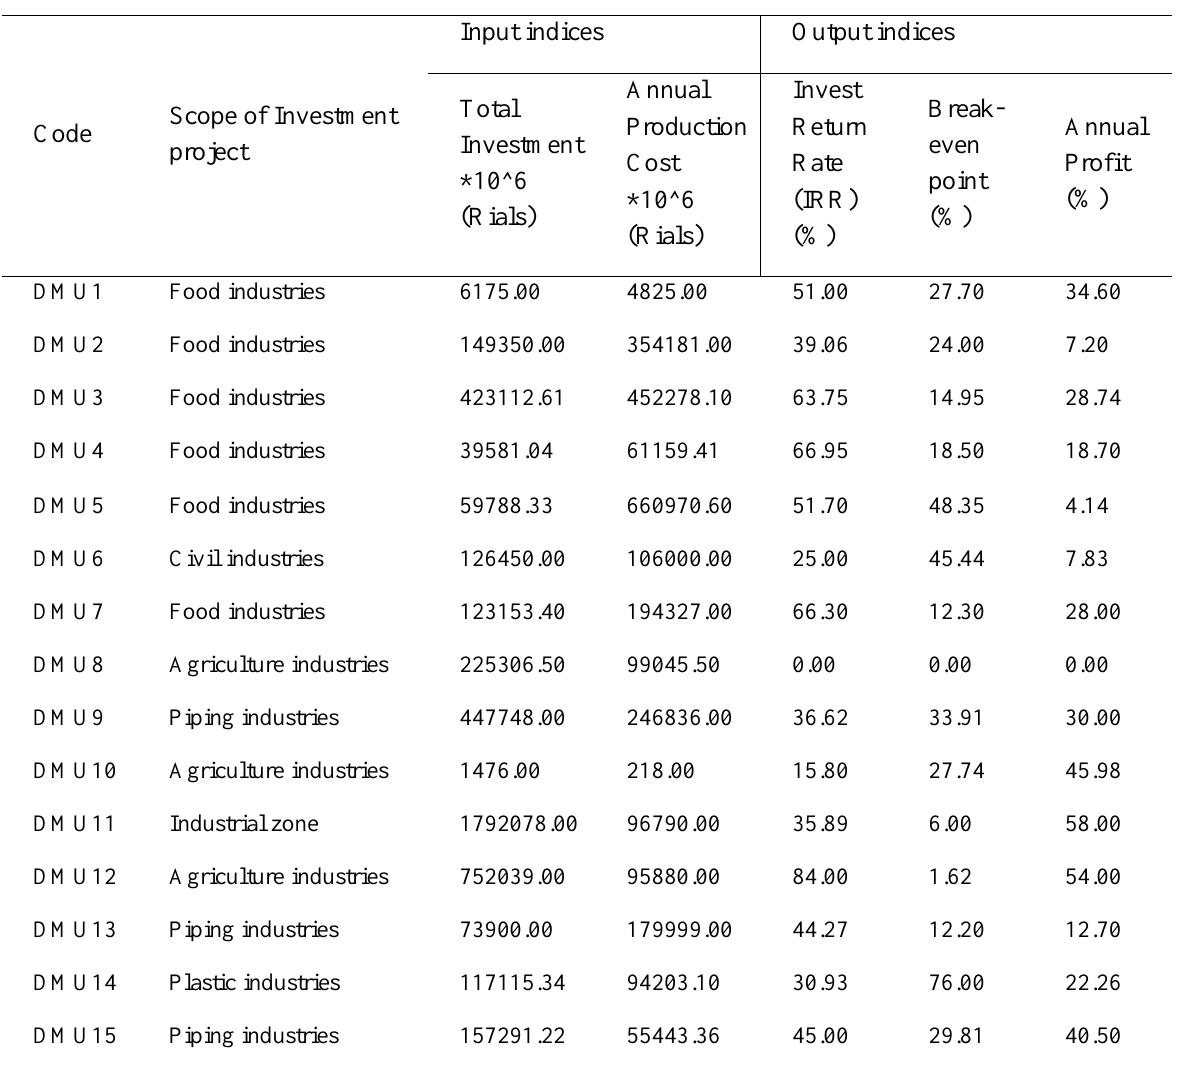
Table 1. Raw Data of